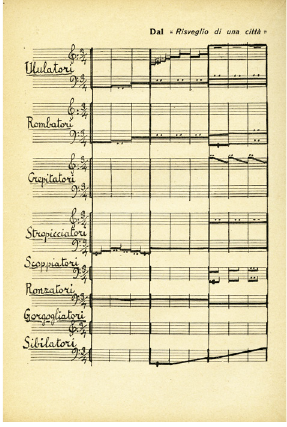
Fig. 23 Luigi Russolo, Risveglio